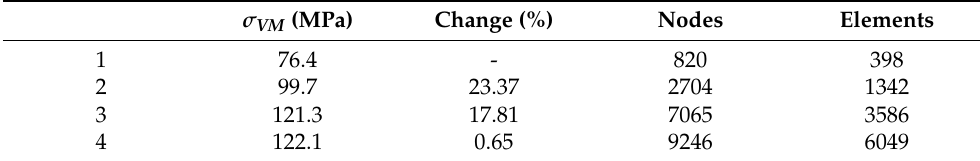
78.102 mm. Table 6. Mesh convergence